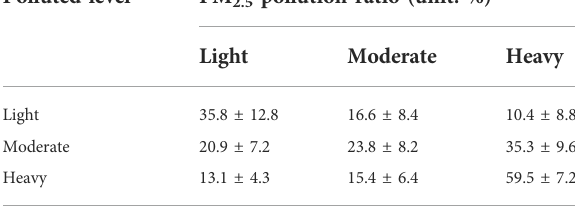
TABLE 2 Average PM 2.5 pollution ratios at different polluted levels in BTH and its surrounding areas.